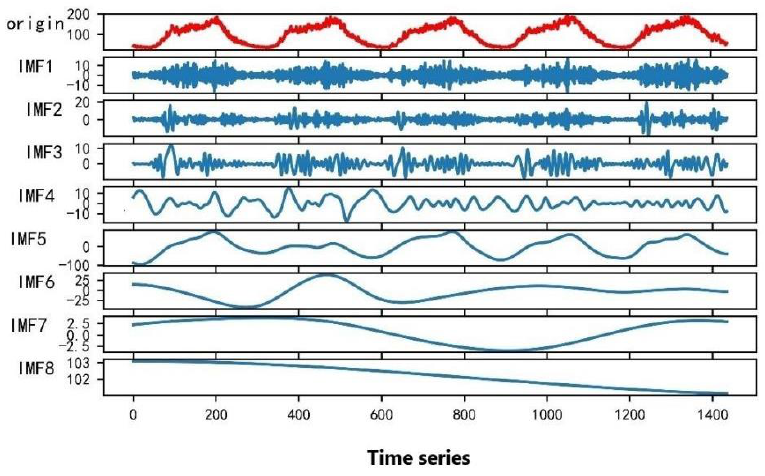
Figure 6. CEEMDAN decomposition of traffic flow time series graph.